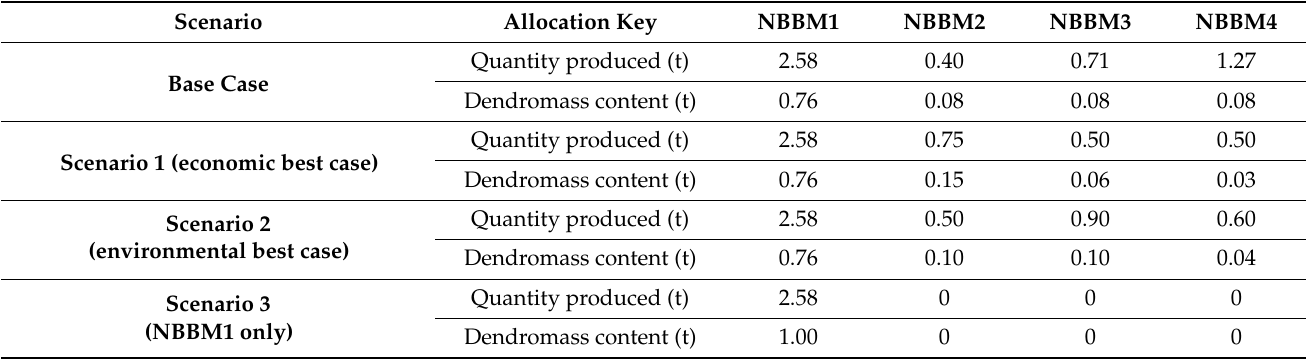
Table 1. Distribution of dendromass to the four product systems in four